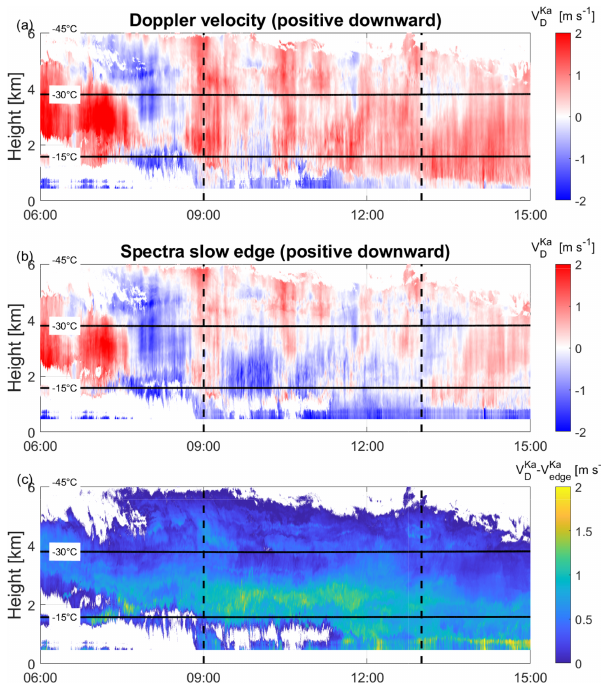
Figure 5. Time–height cross section of the (a) KAZR Doppler velocity V Ka , (b) Doppler velocity of KAZR spectra slow edge D V Ka , (c) difference between KAZR Doppler velocity and D , slowedge − V Ka Doppler spectra slow edge V Ka . The horizontal black D D , slowedge lines indicate the − 15 and − 30 ◦ C levels while the vertical dashed lines delimit the period of large DWR Ka , W used to produce the den- sity plots in Figs. 7, 8 and